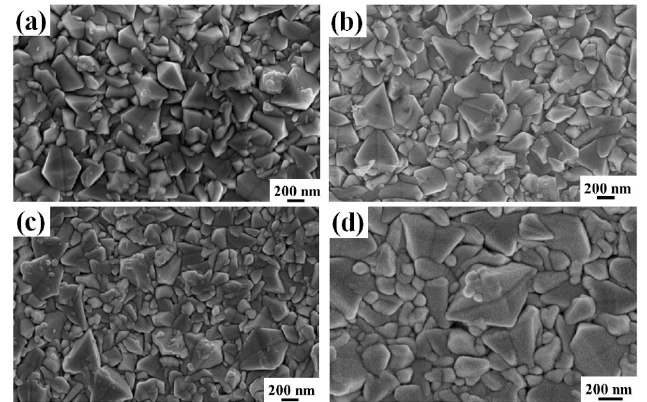
Figure 3. Representative SEM images of the surface of the as-deposited FTO (substrate A) on which the AuPd film is deposited with increasing the amount of deposited AuPd: ( a ) 4.3 nm; ( b ) 7.5 nm; ( c ) 29.2 nm; and ( d ) 48.6 nm.